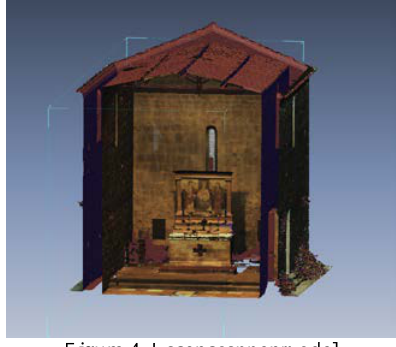
Figure 4. Laser scanner